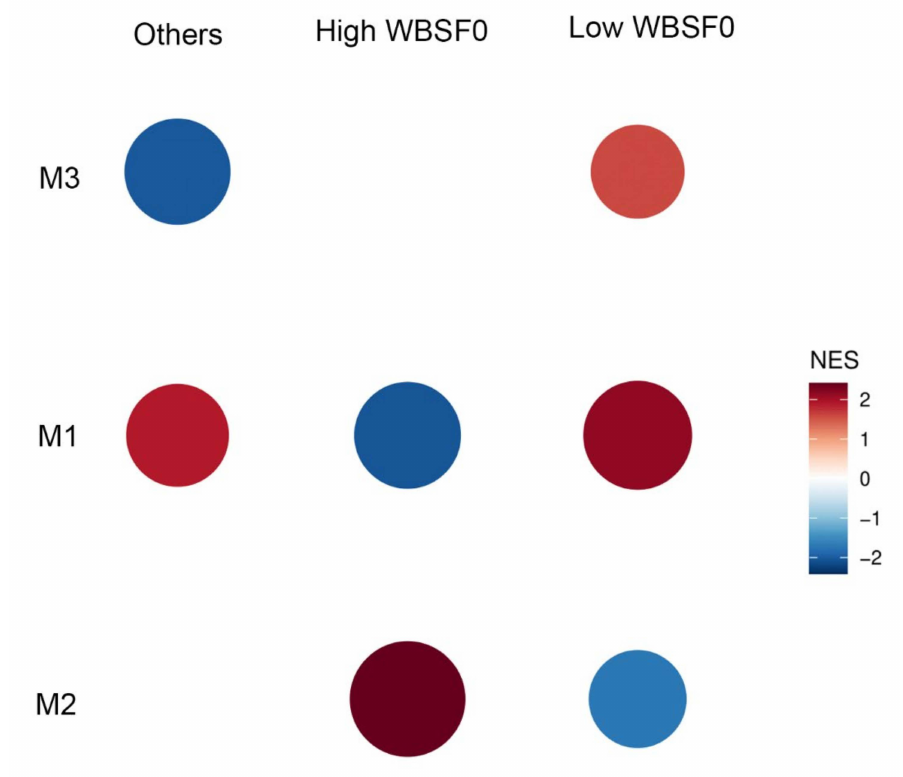
Figure 4. Gene set enrichment analysis of co-expression modules involving DASE genes for WBSF0